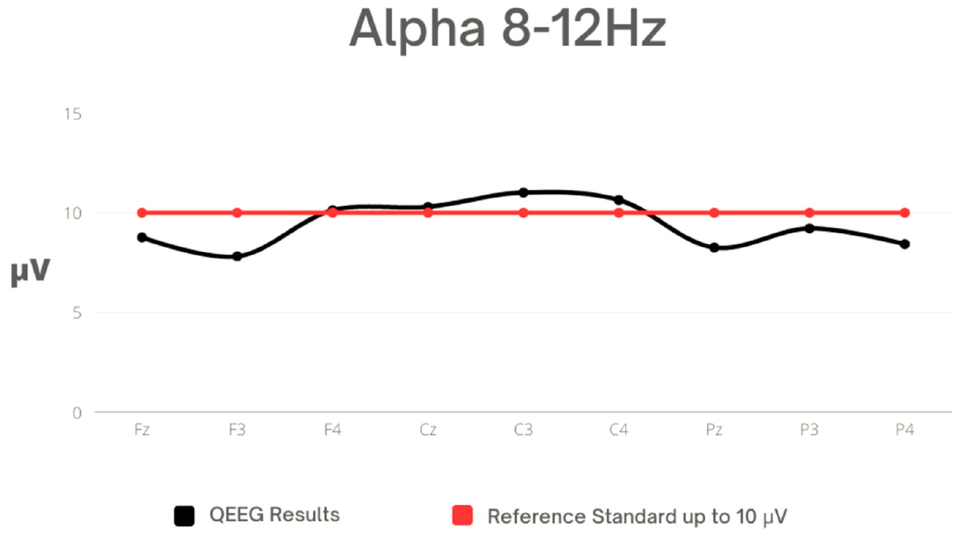
Figure 3. Mean values for Alpha against reference standard.